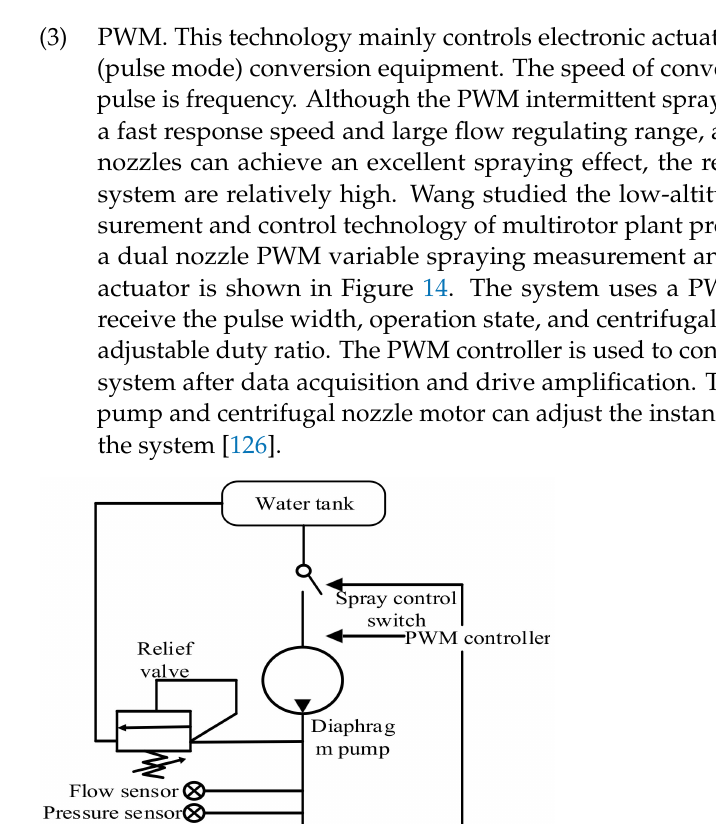
Figure 13. Three-dimensional cutting view of nozzle. 1: Water inlet; 2: Magnetorheological fluid cavity plug; 3: Coil winding shaft; 4: Magnetorheological fluid chamber; 5: Nozzle end cover; 6: Shell body; 7: Conductor hole; 8: Elastic cavity; 9: Swirl chamber.